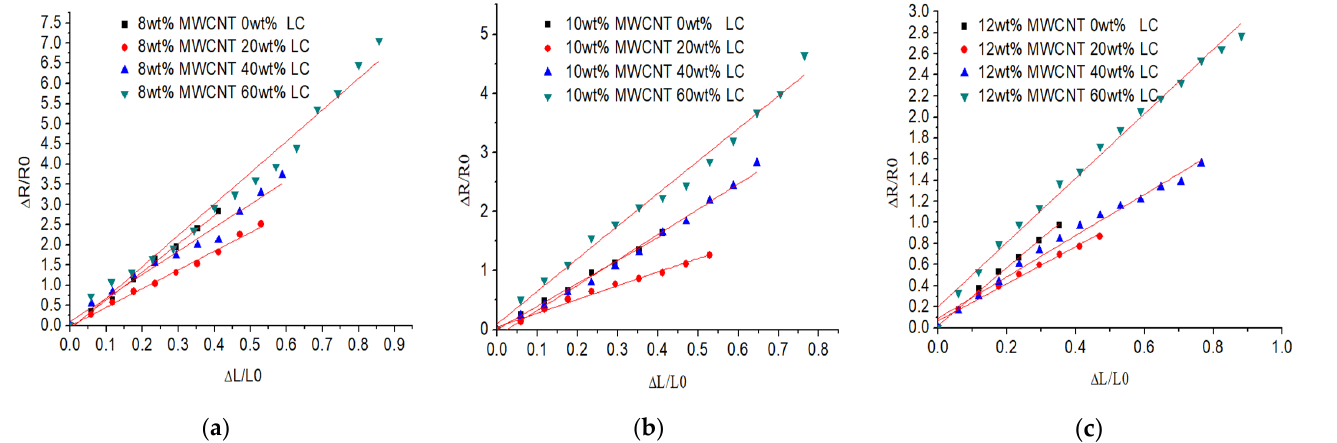
Figure 5. The relative resistance changes under different strain of the tensile sensor with 0–60 wt% LC and MWCNTs of